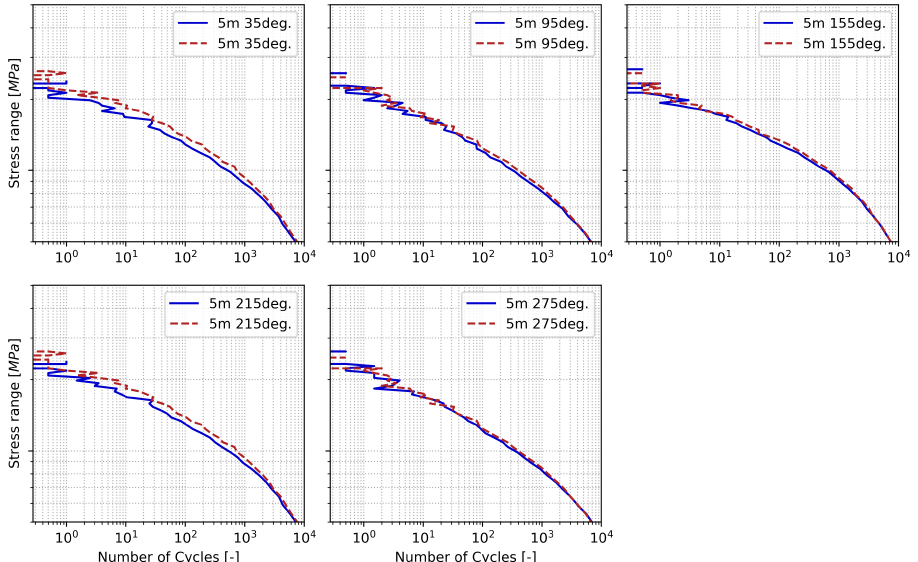
Figure A5. Zoom into fatigue spectra for sensors on the TP with measurement (solid) and estimation (dashed).